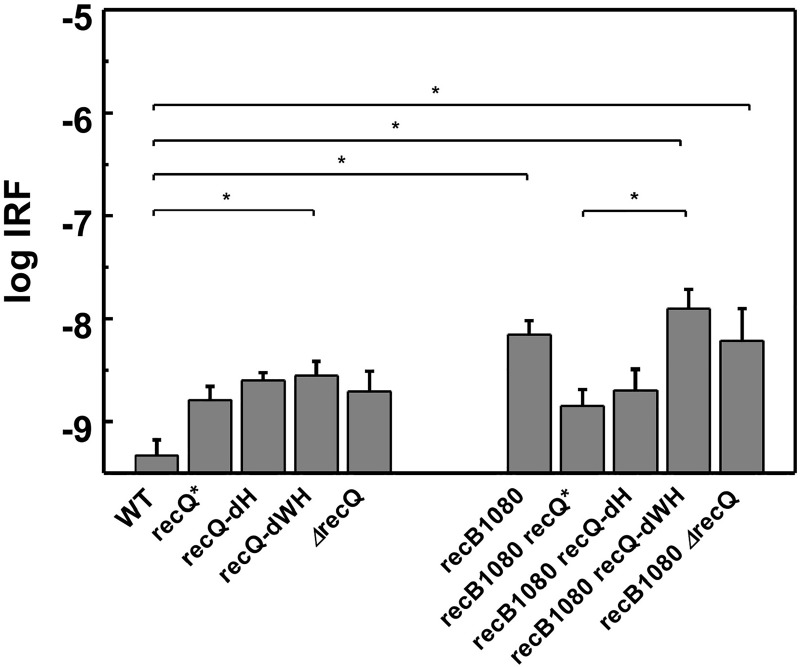
RecQ helicase variants with enhanced processivity ameliorate RecB1080-induced impairment of recombination accuracy.UV-free IRF values of E. coli strains (mean ± SE) are shown. Asterisks indicate significant pairwise differences (ANOVA, Tukey’s post-hoc test, p < 0.05). Data for non-recB1080 strains are from ref. [15]. Determined parameters, sample sizes and statistical p values are listed in S5 and S6 Tables.